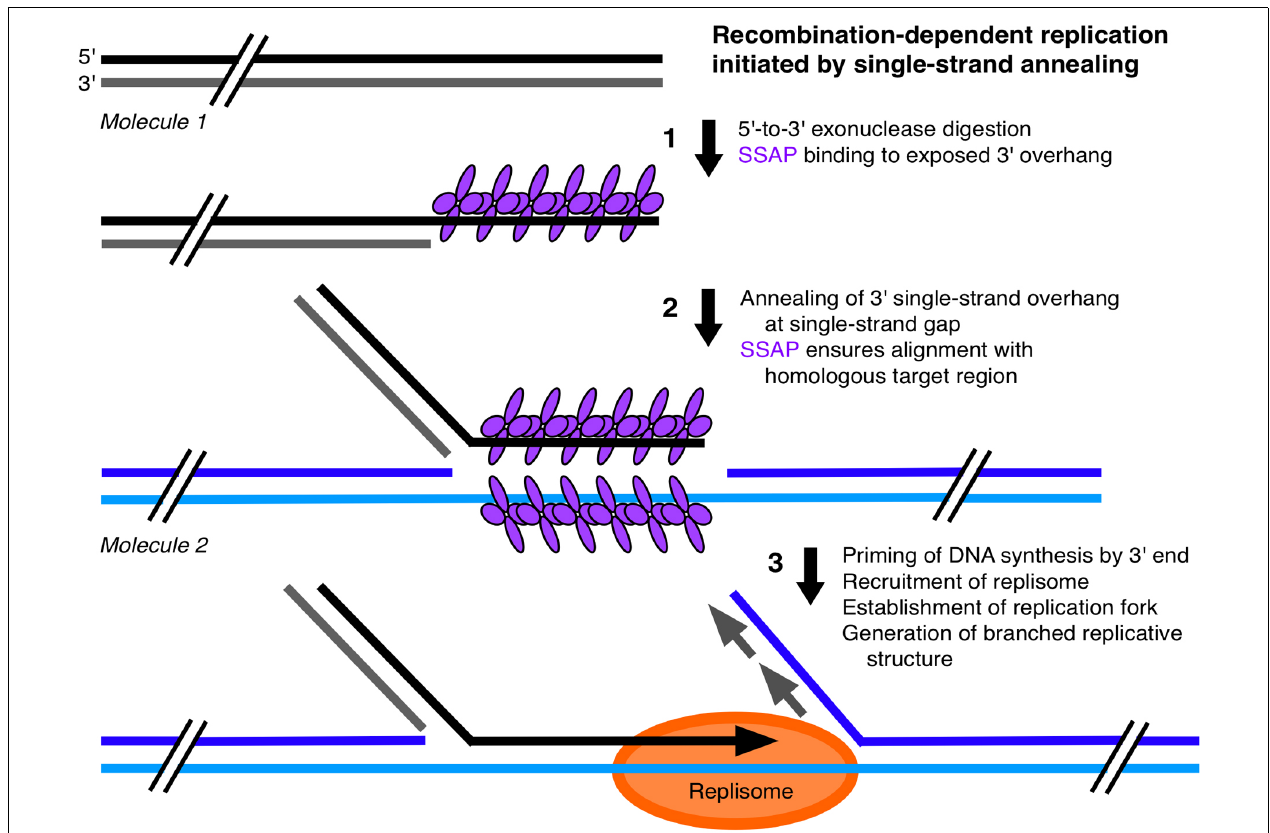
FIGURE 3 | Single-strand annealing mechanism for plastid DNA replication. This single-strand annealing (SSA), recombination-dependent replication model for ptDNA is based on a replication mechanism for herpes virus DNA (Weller and Sawitzke, 2014). (1) A 3 ′ -overhang is generated by 5 ′ -to-3 ′ exonuclease digestion at the end of a unit-genome-sized monomer. A single-strand annealing protein (SSAP) binds to a 3 ′ -overhang. (2) Annealing of the 3 ′ -overhang of Molecule 1 to a homologous single-strand gap in another ptDNA molecule ( Molecule 2 ). (3) Replication is initiated by priming at the 3 ′ -end, assembly of the replisome, and formation of a replication fork, leading to a branched-linear structure. A similar model with the same or analogous proteins applies to the replication of mtDNA in plants. We propose that replication occurs only with ptDNA attached to the nucleoid-on-membrane using single-strand end-binding proteins. Although we propose that Whirly proteins serve attachment and SSAP functions, other single-strand-binding proteins, such as the OSB and RecA families, may also participate in ptDNA replication. Other replication and recombination mechanisms have been described (Cox, 2007; Marechal and Brisson, 2010; Weller and Sawitzke, 2014; Morrical,